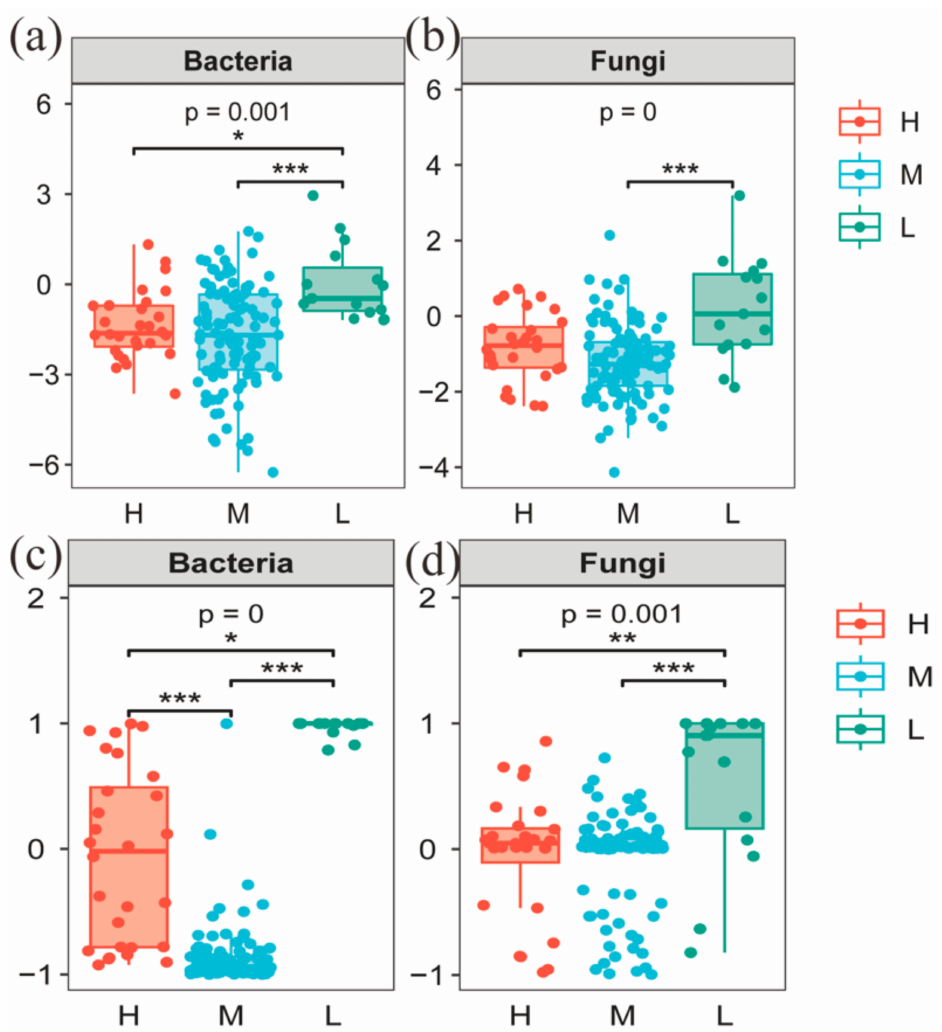
Figure 10. Distribution of β -NTI ( a , c ) and RCbray ( b , d ) in microbial communities on different water- salt gradients. Notes: H, M and L denote high, medium and low water-salt gradients, respectively; *, **, and *** in the figure indicate p < 0.05, p < 0.01, and p < 0.001,